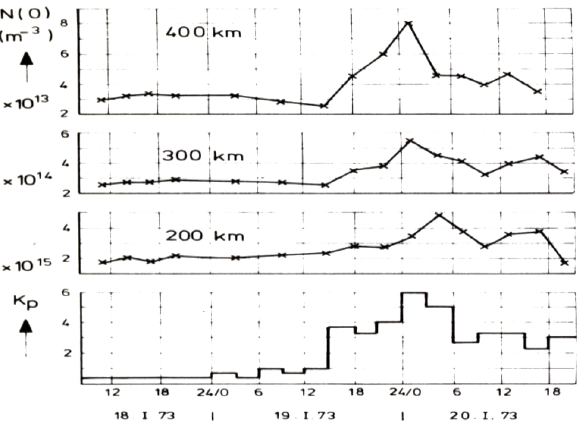
Figure 28. Propagation of geospheric disturbances from polar re- 6. gions toward the equator with time. Density changes of thermo- spheric atomic oxygen are derived from EUV occultation measure- ments (Schmidtke, 1975; copyright permission granted by Wiley publishing).